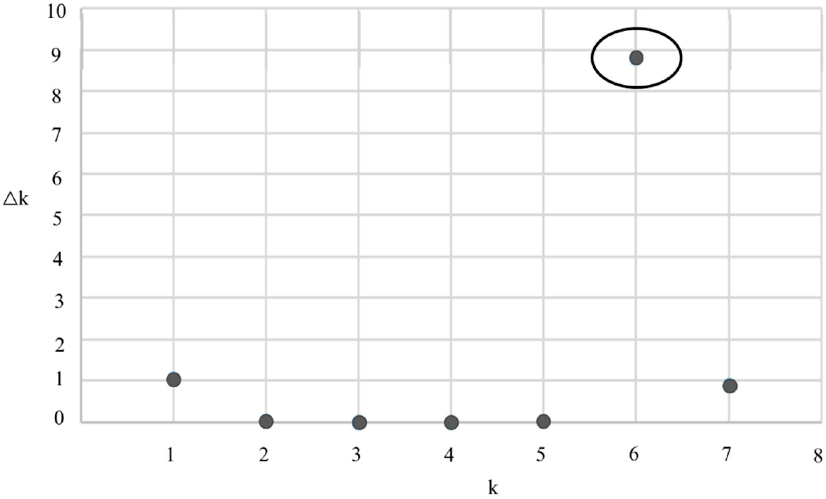
Figure 2. Plot ∆ k values vs. k. Oval encircles point for the optimal number of subpopulations k. The population structure of potato varieties studied was calculated for potential 2 to 7 subpopulations and presented in Figure 3.